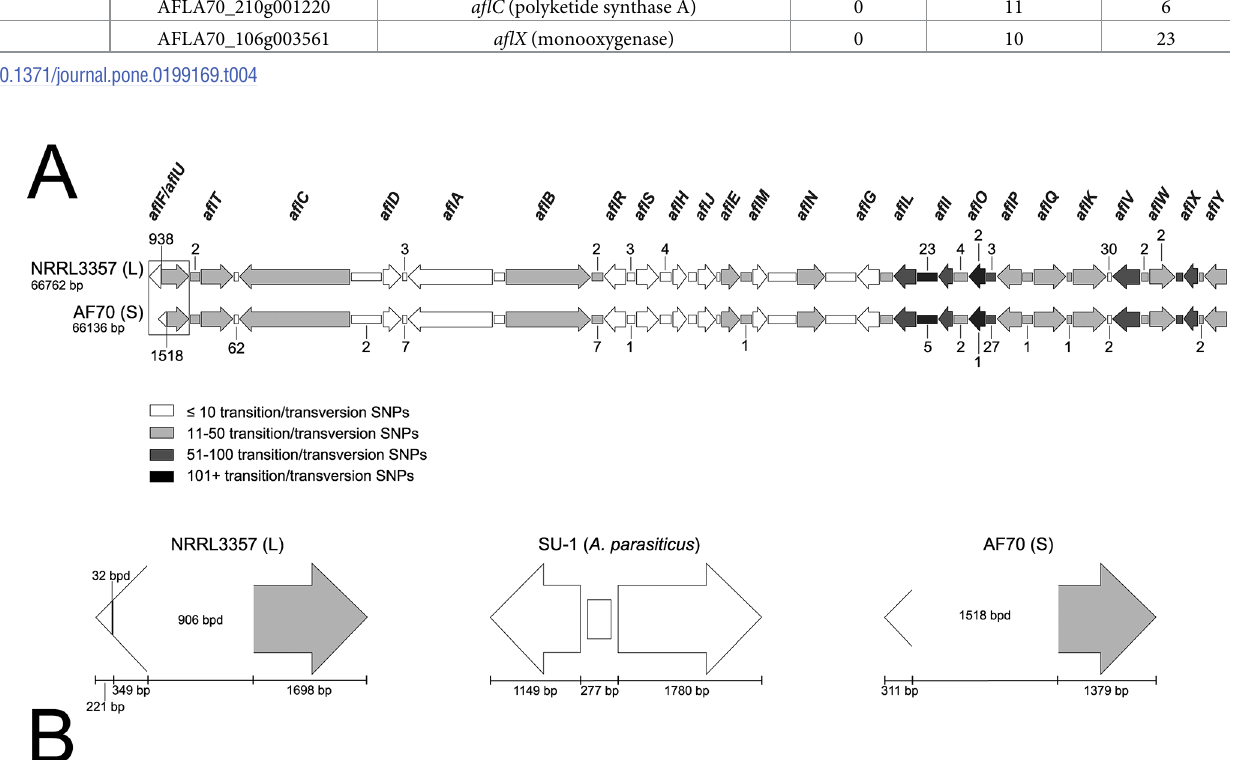
S1 Fig. VCG assay for A . flavus strains AF70 (S-morphotype) and NRRL 3357 (L-morpho- type). The results here illustrate a lack of cleft formation between mycelia of AF70 and NRRL